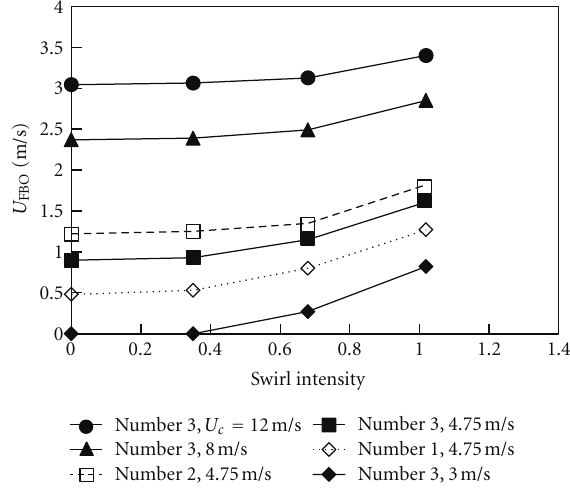
Figure 3: Equivalence ratio gradients at the exit from the di ff erent premixing assemblies. Figure 4: Stability performance of the three premixer/burner set ups at various operating